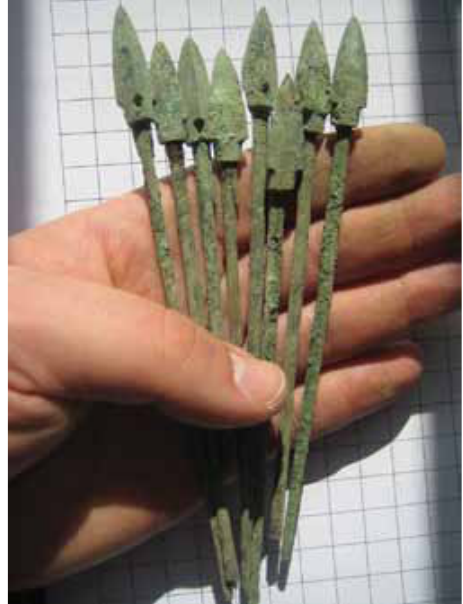
Fig. 8: A handful of the 40,000 bronze arrows so far recovered from the Terracotta Army.